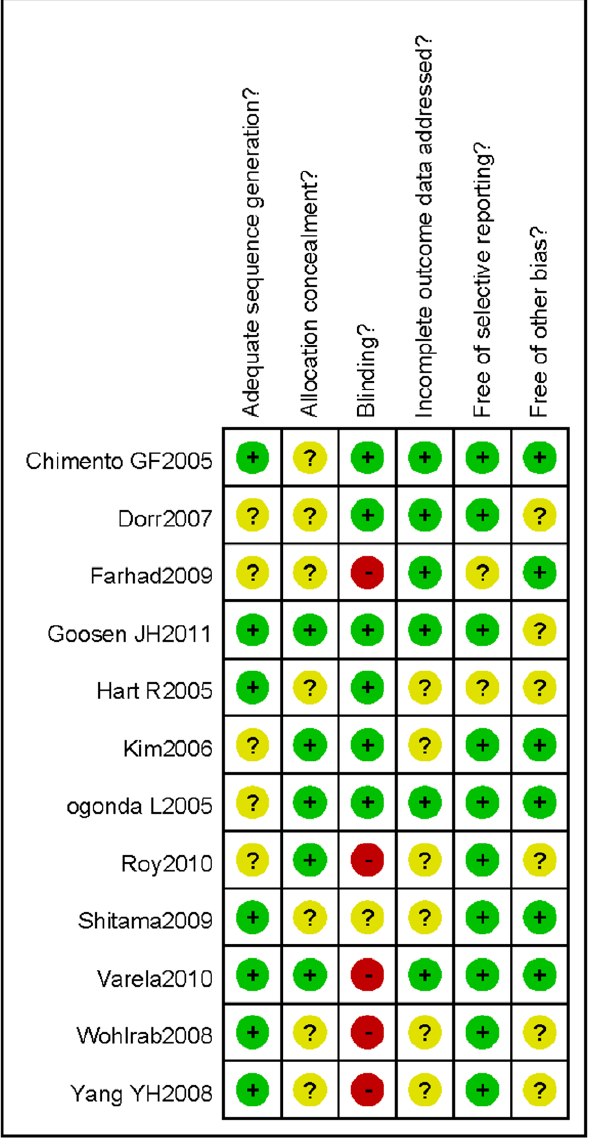
Figure 2. Risk of bias summary. A review of the authors’ judgments about each risk of bias item for each included study. + is ‘‘yes’’, 2 is ‘‘no’’,?is ‘‘unclear’’.